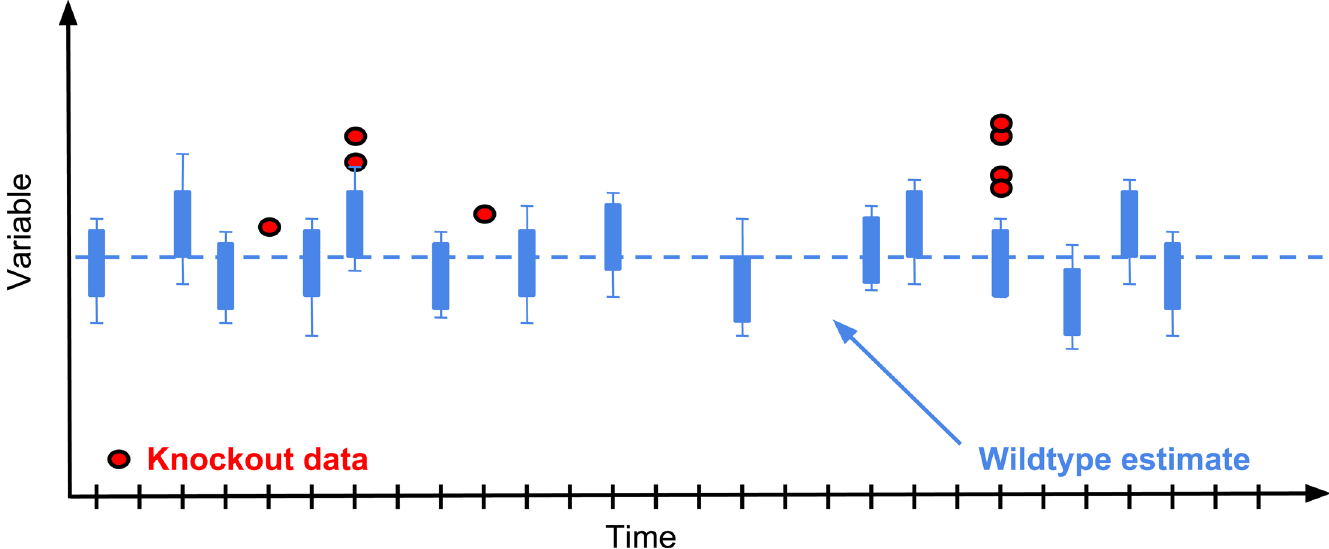
Fig 3. Graphical representation of a typical Mixed Model data structure. The Mixed Model analysis requires a data structure where there are multiple batches of knockout animals and regular batches of control animals. The analysis does not require concurrent controls.